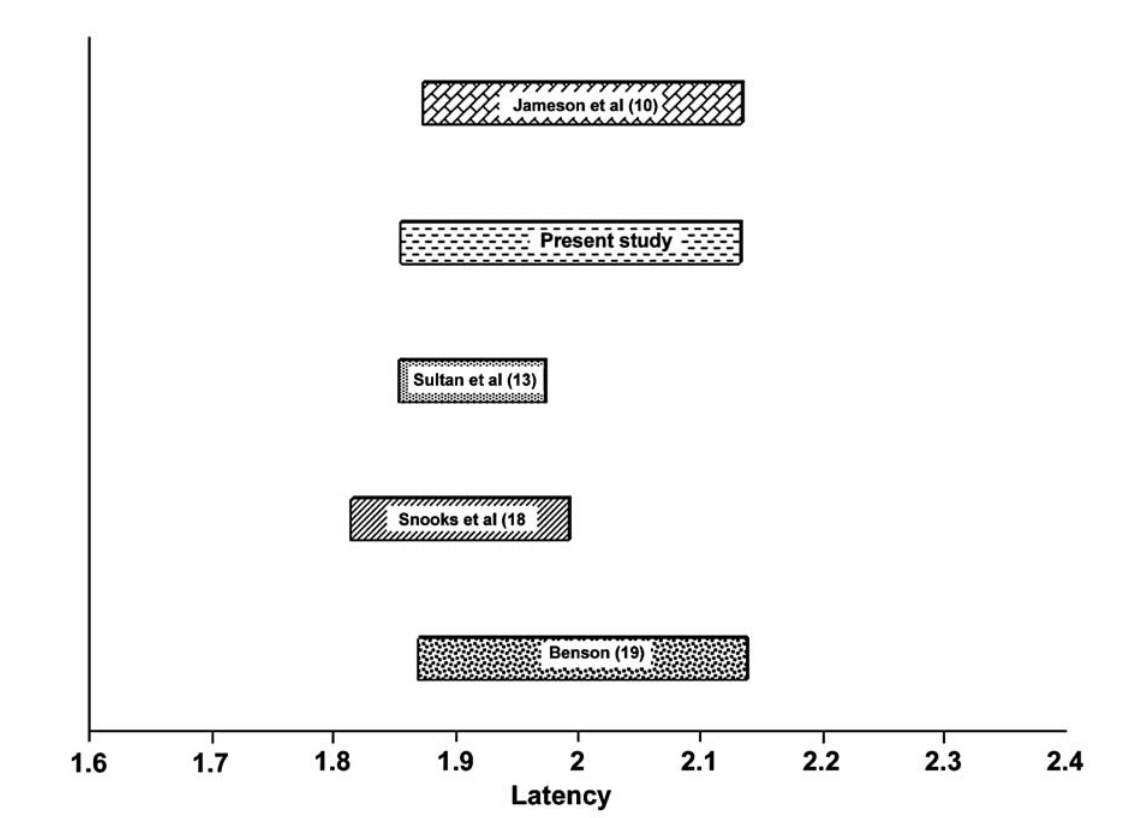
Figure 3 – Pudendal nerve distal motor latency value, corresponding to the arithmetic mean added and subtracted of 2 standard errors in the present study and in comparable literature studies. Ref. 10 = 51 women via transrectal approach; ref. 13 = 57 women via transrectal approach; ref. 18 = 20 women via transrectal approach; ref 19 = 20 women via transrectal